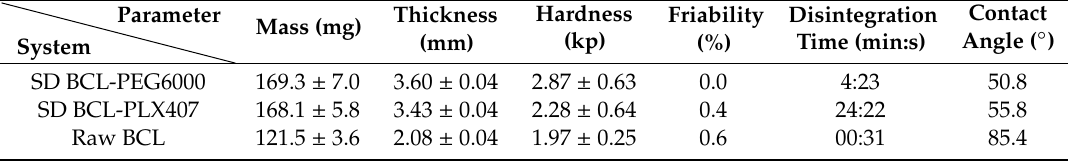
Table 3. The properties of tablets containing solid dispersions (SD) and crystalline bicalutamide.